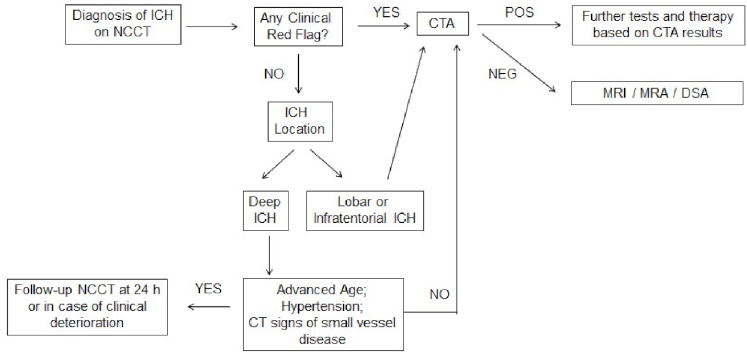
Figure 4. Flowchart for diagnostic work-up in patients with acute